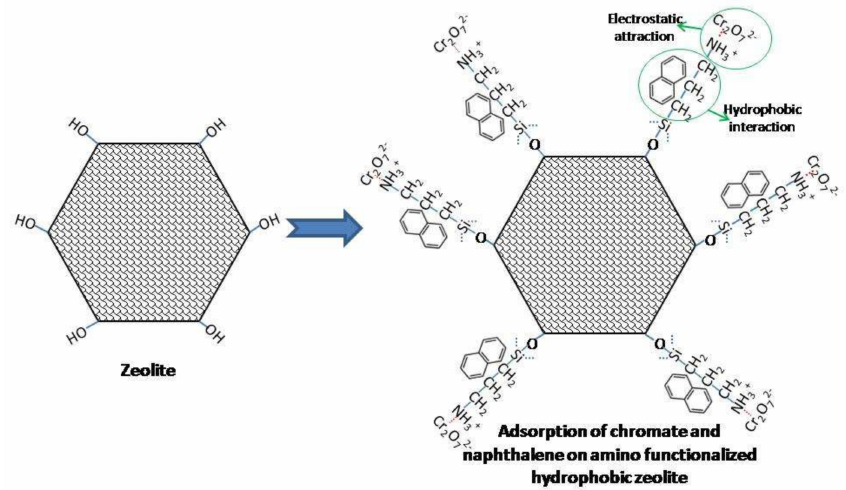
Figure 16. Schematic for modification of natural zeolite and the adsorption process of the amino functionalized hydrophobic zeolite on chromate and